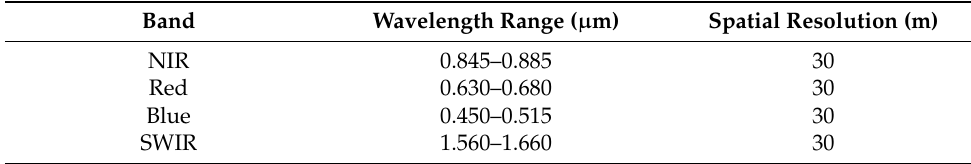
Table 3. Landsat 8 OLI sensor information by